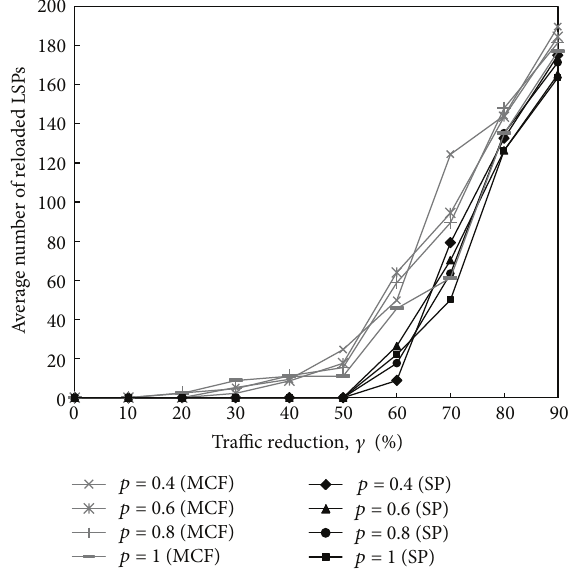
Figure8:NumberofReloadedLSPsusingMEEHeuristicwithMCF and Dijkstra rerouting approach for the Network